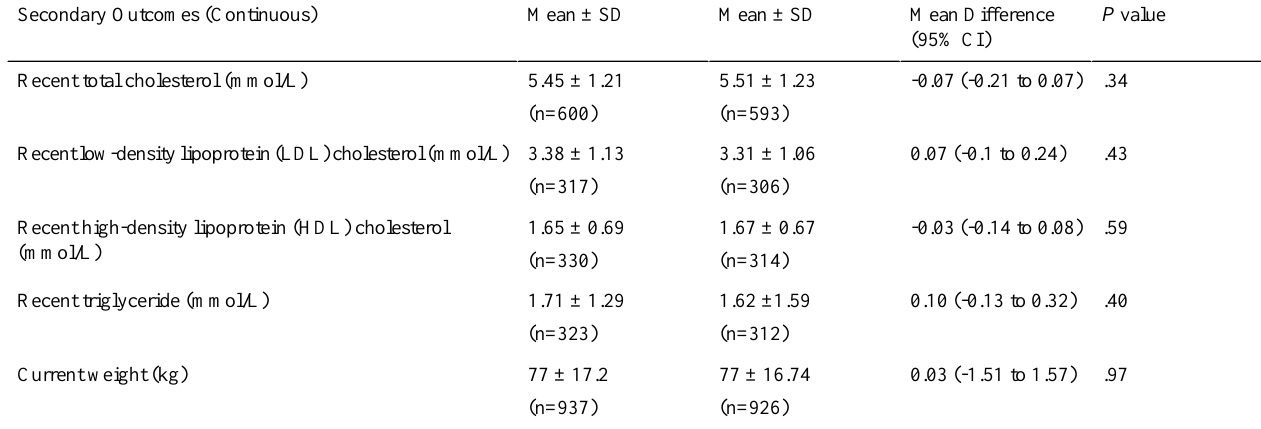
Table 3. Effects of treatment on secondary outcomes (continuous) among randomized